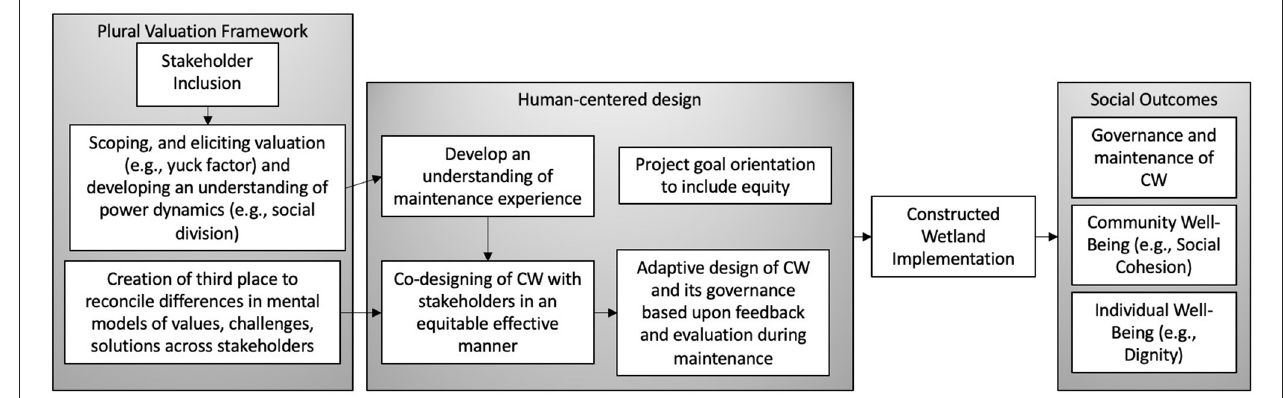
FIGURE 4 | Plural valuation and human-centered design for CW